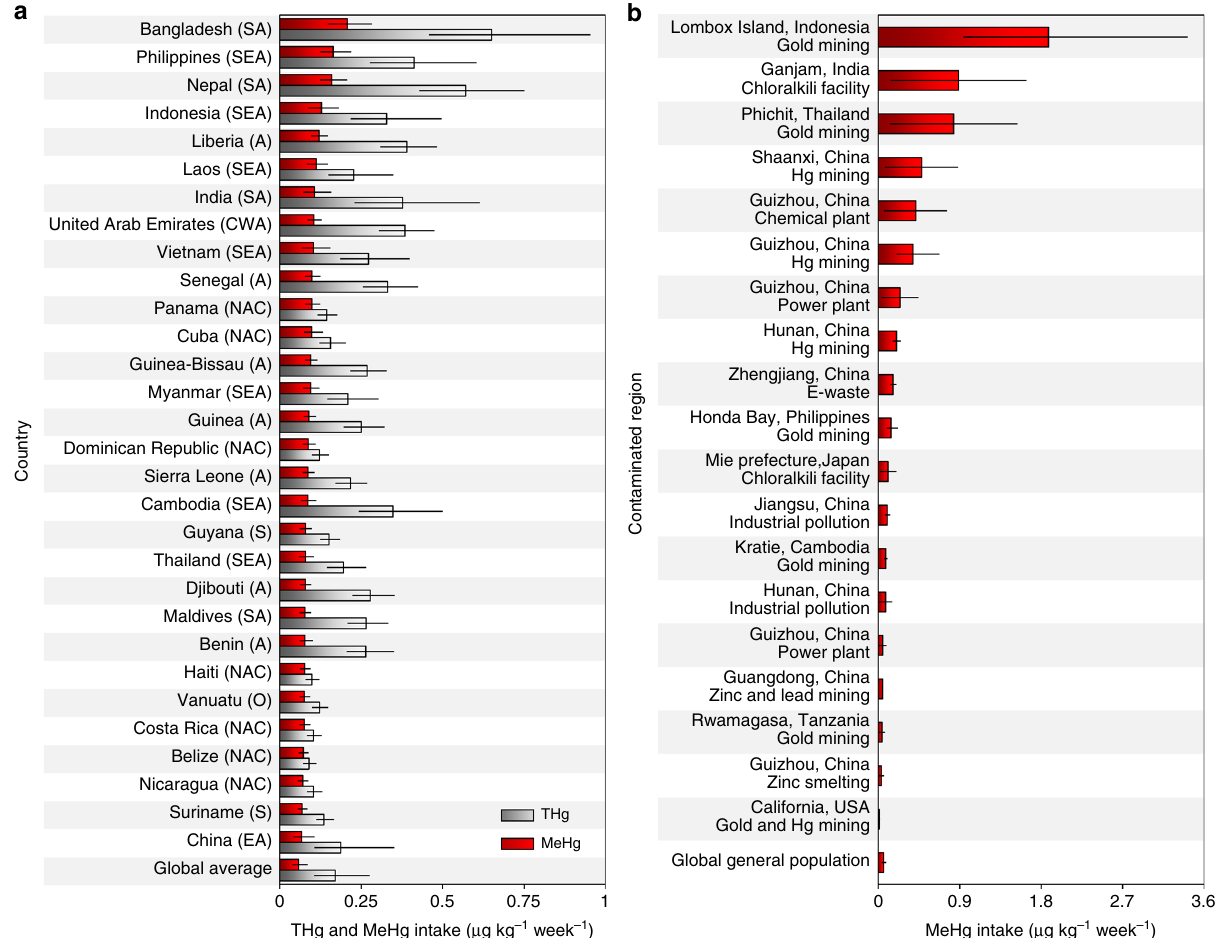
Fig. 3 Human methylmercury intake through rice consumption. a Per capita probable weekly intake (PWI) of THg and MeHg through rice consumption in the top 30 countries and the world average and b PWI of MeHg through consumption of rice from Hg-contaminated regions. Population-weighted world average PWI values of THg and MeHg are shown. More comparison are presented in Supplementary Figs. 17 and 18. A Africa, NAC North America & interquartile range of the con fi dence